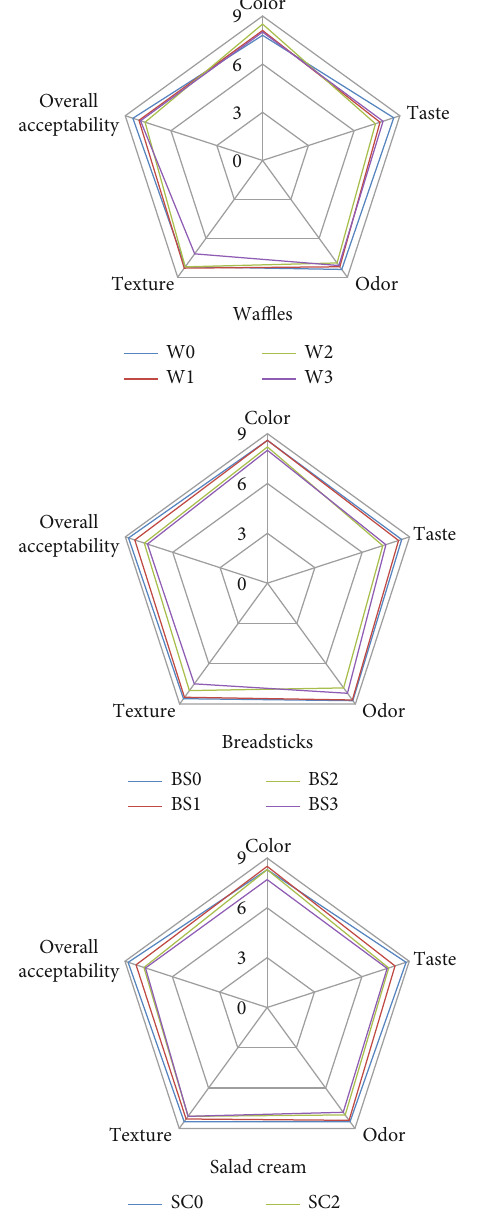
Figure 3: Sensory evaluation of wa ffl es, breadsticks, and salad